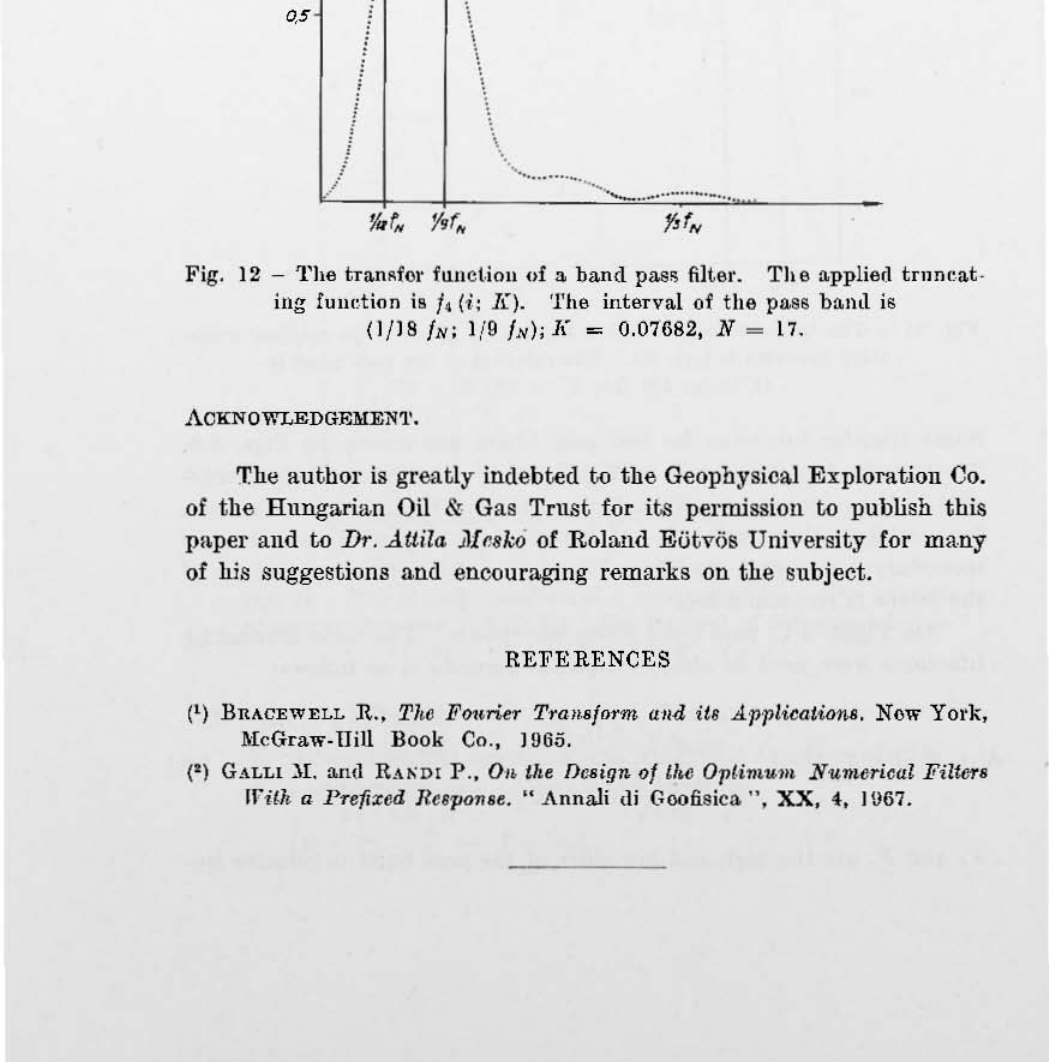
Fig. 12 - 1'h6 tra.n~for fuuct.ioll oi :lo band pass filter. The :l.pplied trllnrat· ing [ulldion is /, (i; lt). 'l'he interval ùf the po.ss balHl is (l/Hl IN; 1(9 IN); li -= 0.07682, N _